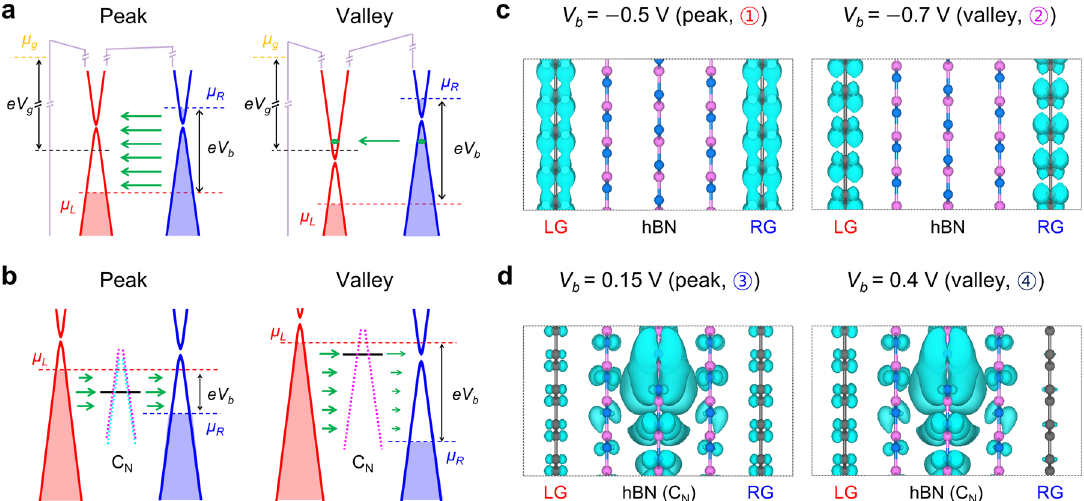
Fig. 5 Schematics of the NDR mechanisms based on the gating and quantum hybridization. a Negatively gated ( V g ¼ (cid:2) 2 : 5 V) pristine 3L hBN case at the NDR peak ( V b ¼ (cid:2) 0 : 5 V, left panel) and NDR valley ( V b ¼ (cid:2) 0 : 7 V, right panel). b Defective 3L hBN case (central C N defect) at the NDR peak ( V b ¼ 0 : 15 V, left panel) and NDR valley ( V b ¼ 0 : 4 V, right panel). The red and blue solid lines indicate the LG and RG Dirac cones, respectively, and green arrows represent the electron fl ow. The chemical potentials of LG ( μ L ) and RG ( μ R ) that de fi ne the bias window with the voltage V b are indicated by the red and blue horizontal dotted lines. In ( b ), pink (cyan) dashed lines represent the hybridization of LG (RG) states with the C N defect level (black solid line). The local DOS for c the pristine 3L hBN case at V b ¼ (cid:2) 0 : 5 V (left panel) and V b ¼ (cid:2) 0 : 7 V (right panel), and for d the defective 3L hBN case at V b ¼ 0 : 15 V (left panel) and V b ¼ 0 : 4 V (right panel). The local DOS were obtained from the energy levels corresponding to transmission peaks (marked as ① , ② ) in the third and second panels of Fig. 2f, respectively, for the pristine 3L hBN case, and as ③ , ④ in the second and third panels of Fig. 3c, respectively, for the defective 3L hBN case. Energy windows of ½(cid:2) 0 : 05eV ; þ 0 : 05eV (cid:3) around the transmission peaks and the isosurface value of 1 × 10 − 5 (1 × 10 − 4 ) states Å (cid:2) 3 were adopted for the pristine (defective) 3L hBN with near-Ohmic lateral homojunction contacts 48 . To reinforce the point defect-mediated quantum-hybridization NDR mechanism in graphene-based vertical 2D vdW heterojunctions, we visualize in Fig. 5c, d the NDR peak (left panels) and valley (right panels) local DOS around transmission peaks obtained from the pristine and C N defect-hBN cases, respectively. It can be noted that in the pristine hBN case (Fig. 5c) the in-phase (out-of-phase) local DOS are mainly located at the LG and RG electrode regions at the NDR peak (valley), reaf fi rming the tunneling mechanism. On the other hand, in the C N defect case (Fig. 5d), the local DOS have signi fi cant weights within the defective hBN region. Furthermore, the NDR peak (valley) is generated from the high (low) level of wavefunc- tion delocalization, as evidenced by the presence (absence) of local DOS weight on the RG region at positive V b regimes.